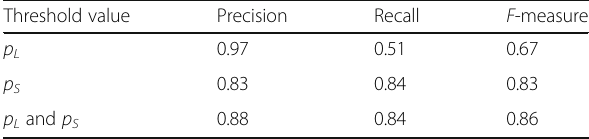
Table 2 Precision, recall, and F -measure for dust storm calculated from all of the five test images. The two threshold values, p L and p S , are 0.95 and 0.5,